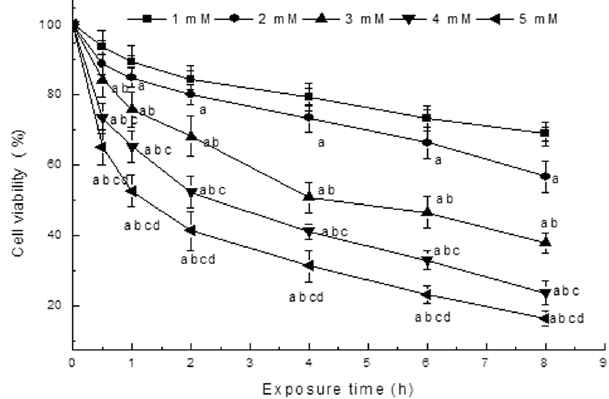
Figure 1. The viability of DRG cells after treatment with different ropivacaine hydrochloride concentrations and exposure times ( x ± s, %, n = 8). a P < 0.05 vs. 1 mM group, b P < 0.05 vs. 2 mM group, c P < 0.05 vs. 3 mM group, d P < 0.05 vs. 4 mM group.